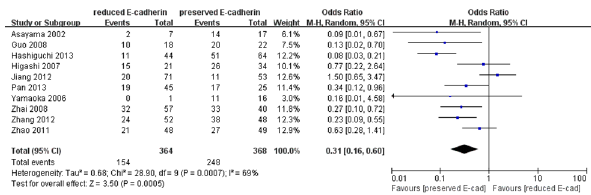
Figure 5. Forest plot displaying the results of the meta-analysis on metastasis.